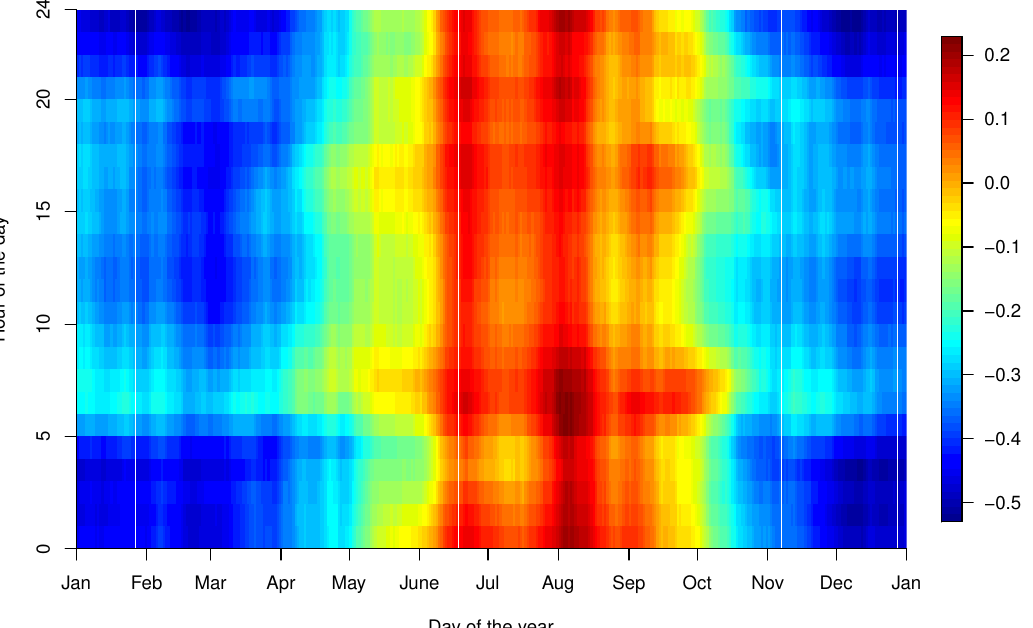
Figure 7: Conditional Kendall’s tau between electricity consumption and temperature given the day of the year ( h *,1 = 12 days) and the time of the day (in hours, h *,2 = 1